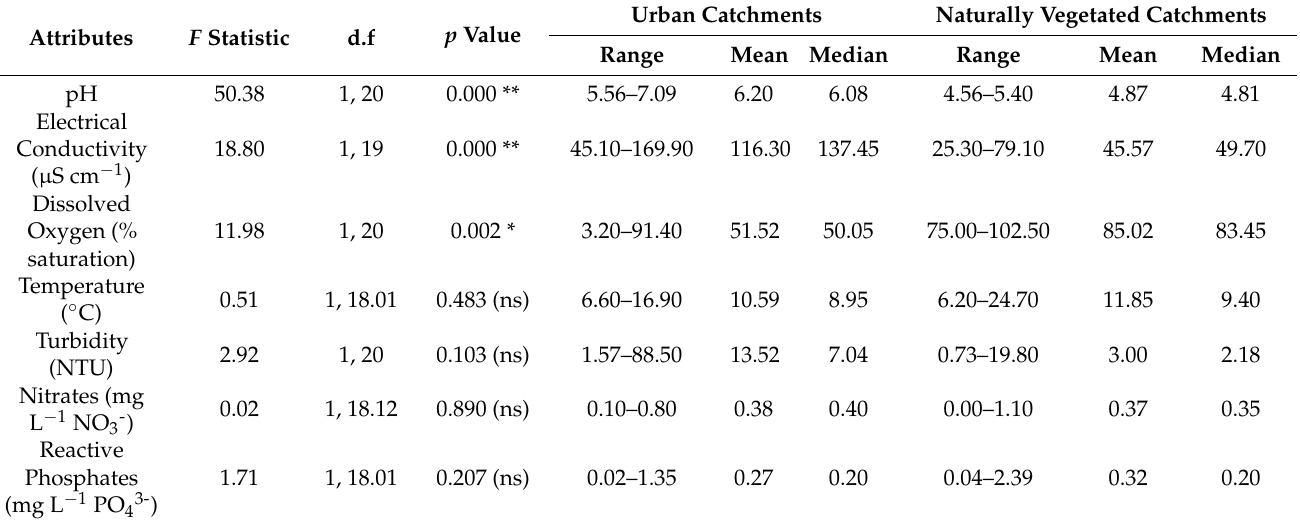
Table 2. Summary of water physiochemical properties for Temperate Highland Peat Swamps on Sandstone (THPSS) in urban ( n = 4) and naturally vegetated ( n = 4) catchments from April–June 2018